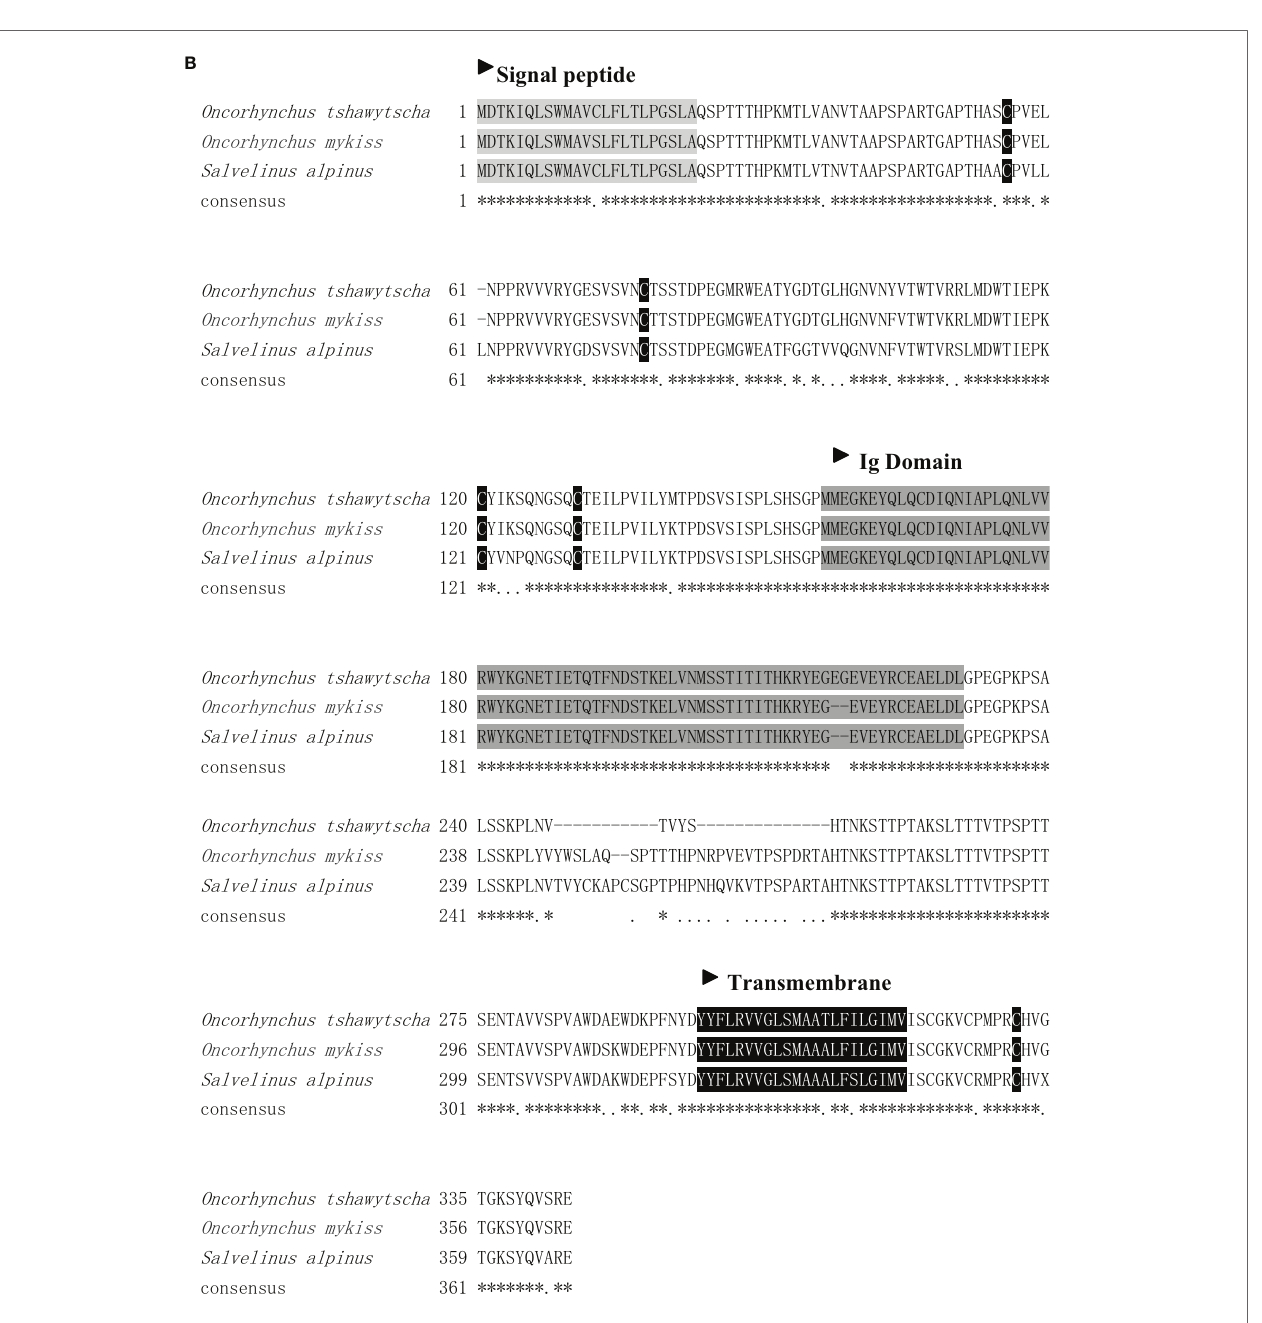
FIGURE 1 | The nucleotide and deduced amino acid sequences (A) and multiple sequence alignment of deduced amino acid sequences (B) of ICAM-1 chain in rainbow trout and other teleost fi sh. Signal peptide is illumed with light gray. Cysteine is circled with the pane. The Ig domain is shaded in dark gray. The transmembrane is marked in black. *Indicates the similarity of the observed in the head kidney and spleen after IHNV infection in comparison with the control group ( Supplementary Figure 2C ).